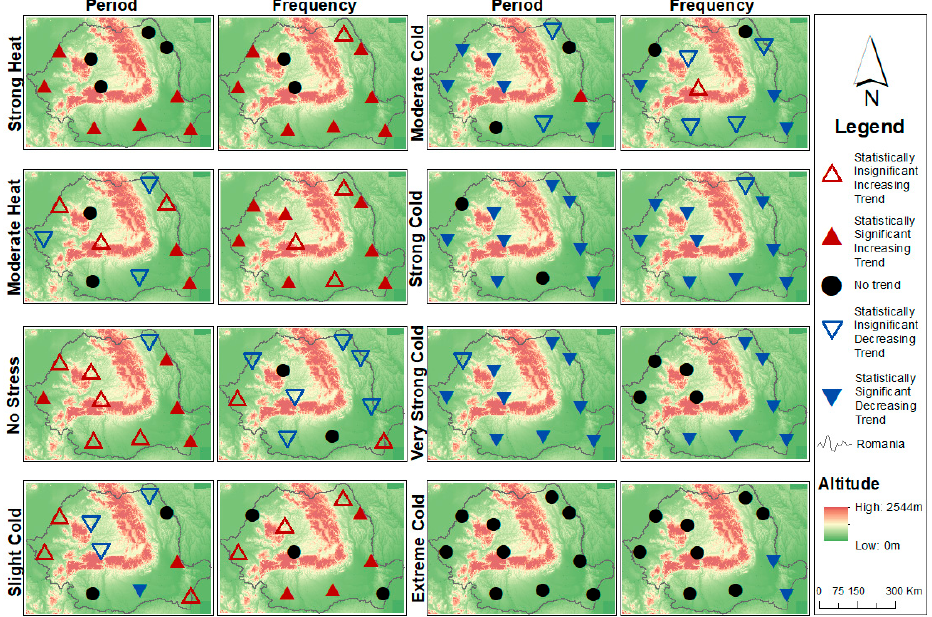
Figure 13. Spatial distribution of the trends detected for the UTCI index.